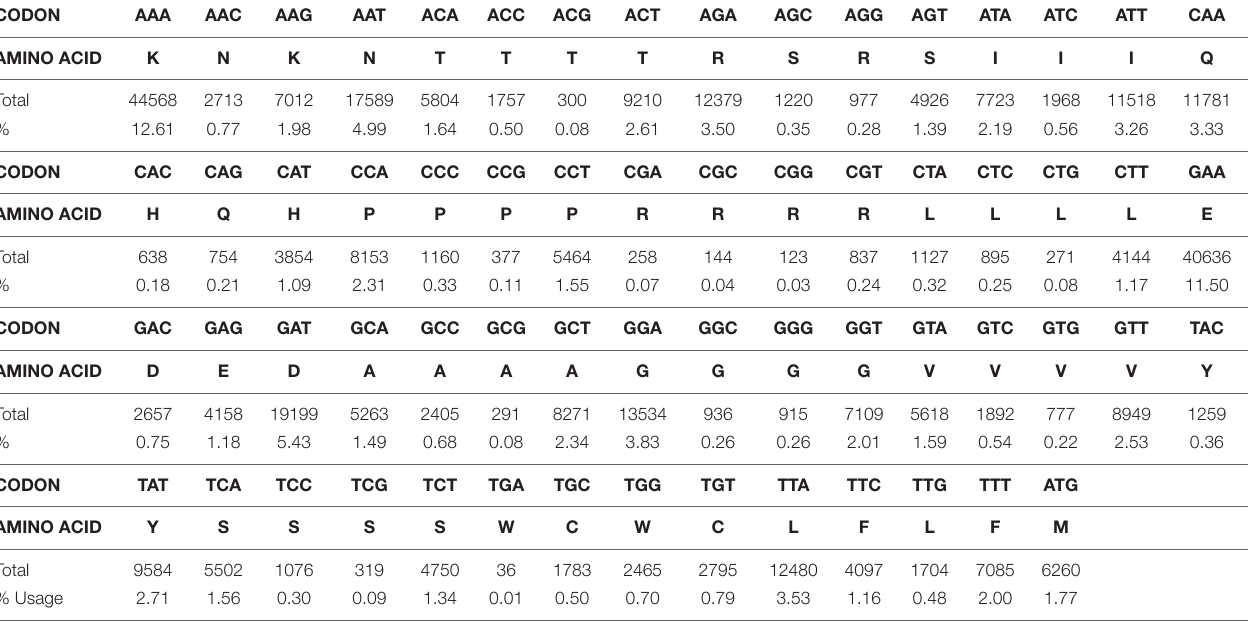
TABLE 3 | Codon usage for sequence data obtained for the cDNA library.